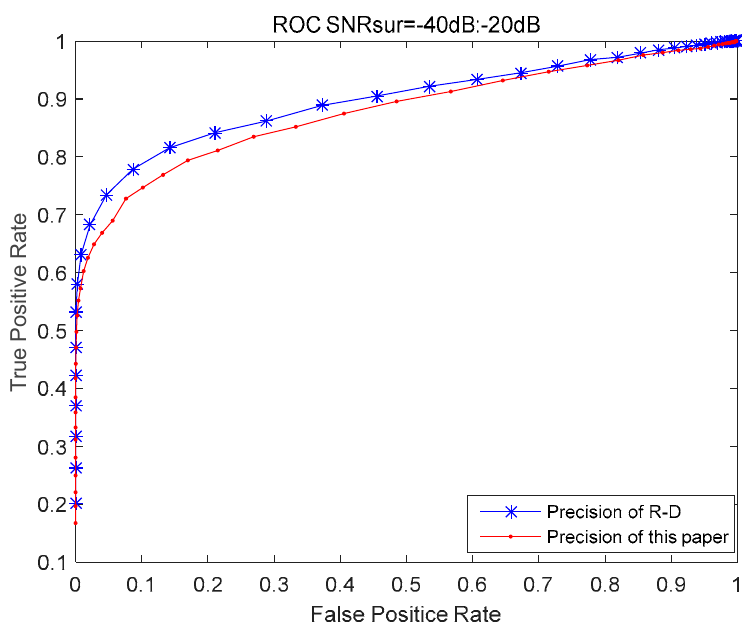
Figure 15. Comparison of ROC curve with SNR ref = − 5 dB ( N = 10 4 ).